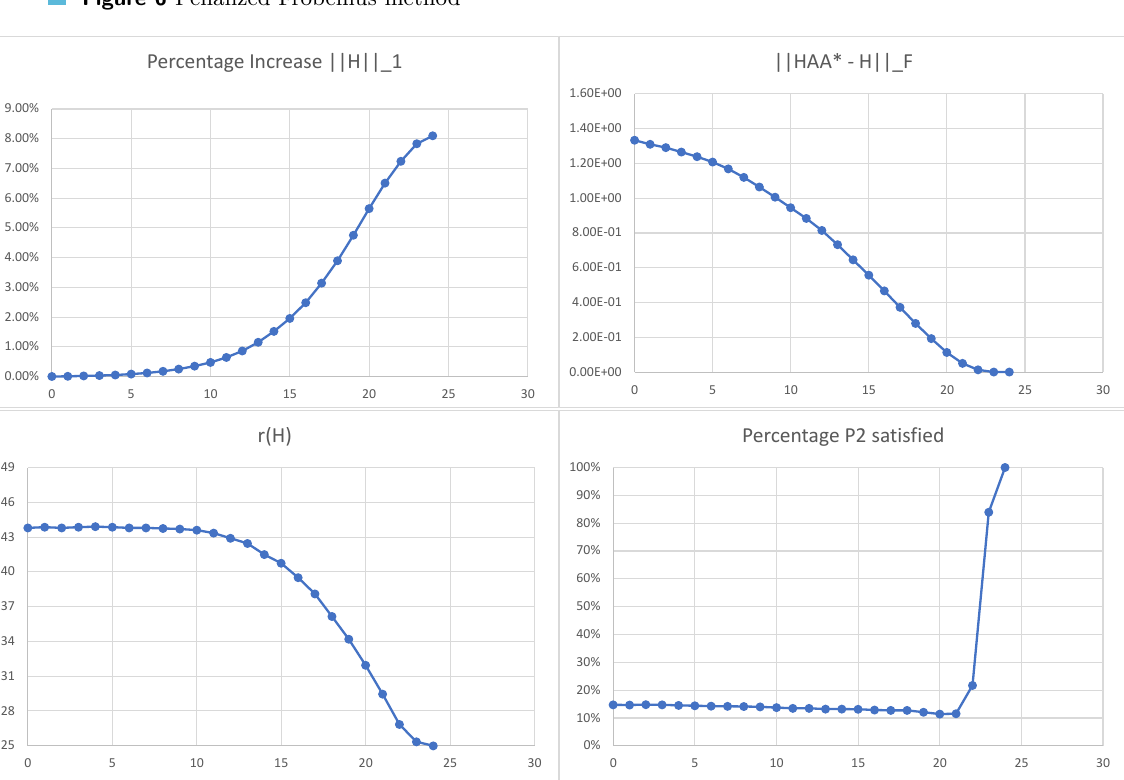
Figure 7 Nuclear-norm